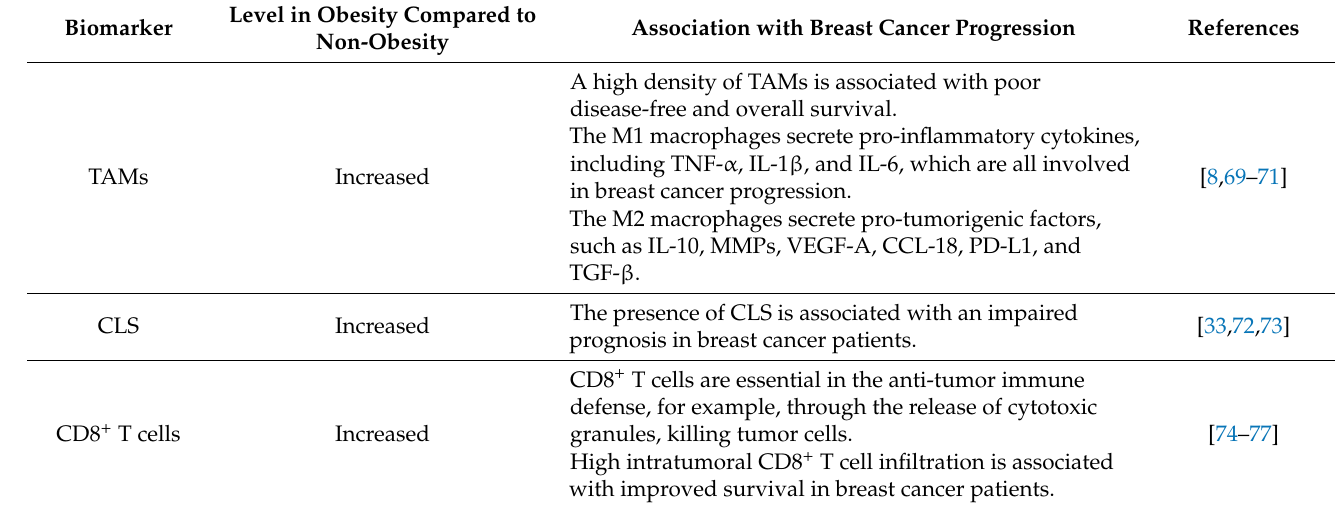
Table 2. Local obesity-associated inflammatory biomarkers involved in breast cancer